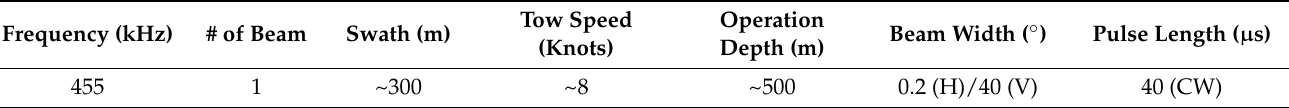
Table 2. Acquisition specifications of our side scan sonar